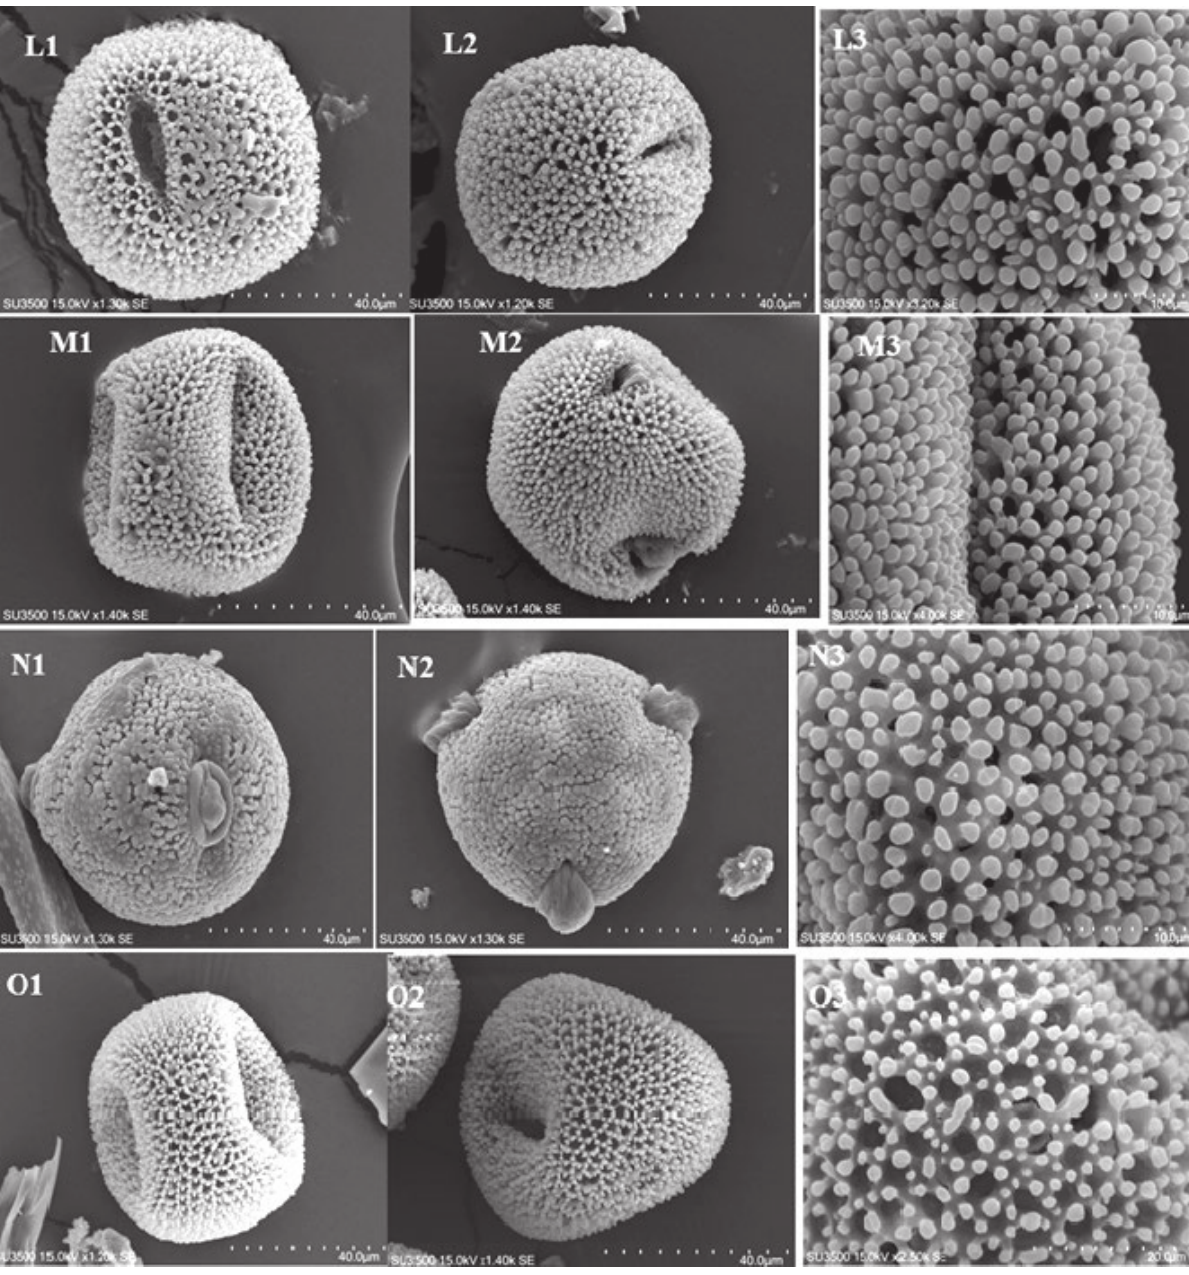
Figure 4. Pollen micrographs of Geranium species: L1-L3: G. rotundifollium, M1-M3: G. lucidum, N1-N3: G. albanum , O1-O3: G. purpure- um ; L1, M1, N1, O1 – equatorial view; L2, M2, N2, O2 - polar view; L3, M3, N3, O3 -exine